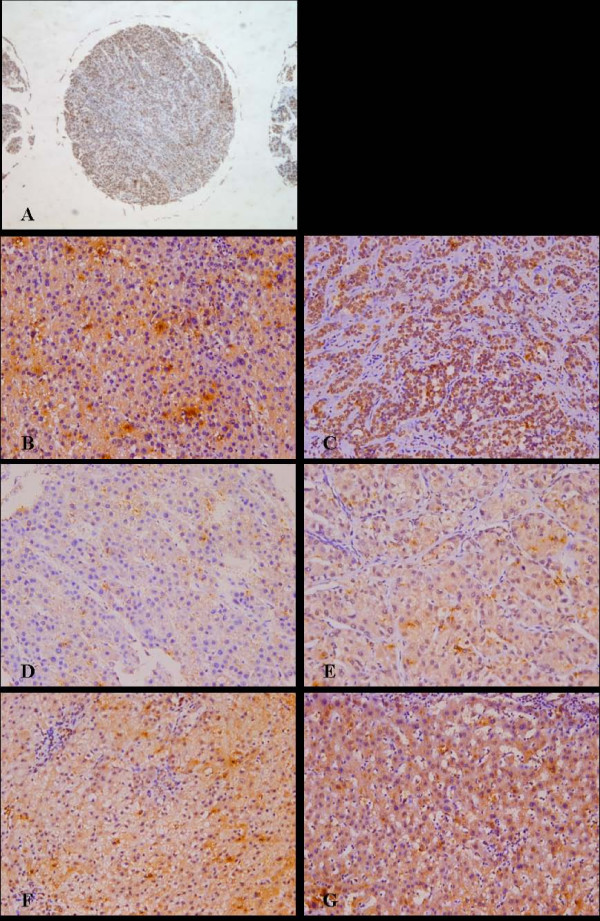
CXCR4 expression in HCC TMAs. Representative CXCR4 staining. (A): CXCR4 staining in a single tissue core with a 1-mm diameter (× 50). (B): Cytoplasmic CXCR4 staining. (C): Nuclear CXCR4 staining. (D-G): Examples of weak (+) (D), moderate (++) (E), strong (+++) (F), and very strong staining (++++) (G). All images are × 200 magnification unless otherwise noted.